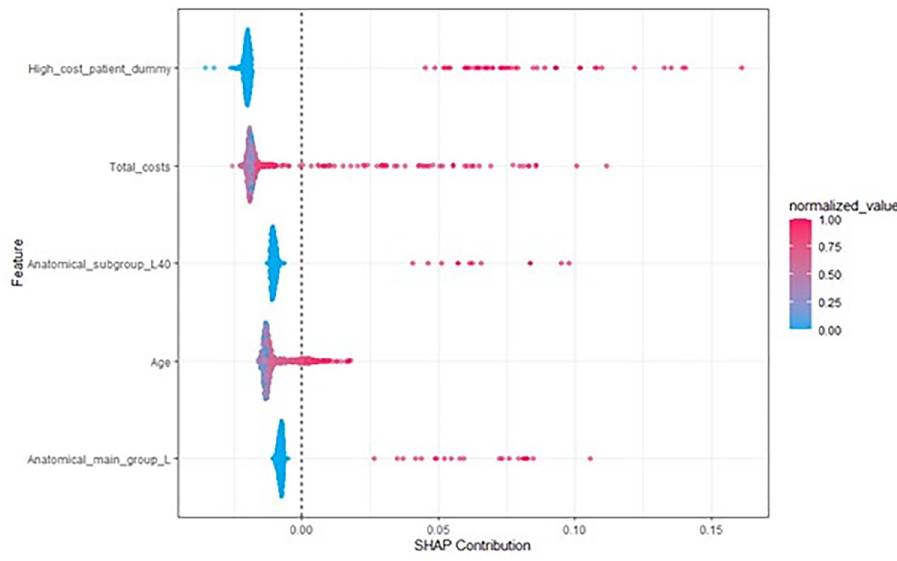
Fig 4. SHAP analysis for the random forest on test data. Each dot represents an